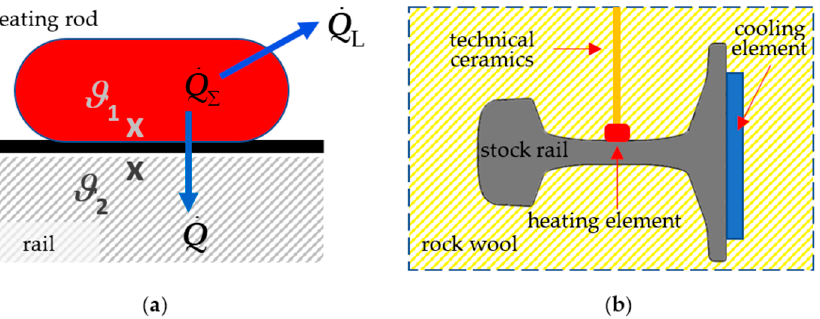
Figure 10. ( a ) Connection of heating rod and rail with the respective temperatures and heat flow to calculate the thermal contact resistance; ( b ) Experimental setup to measure thermal contact resistance dependent on the joint force between heating rod and rail.